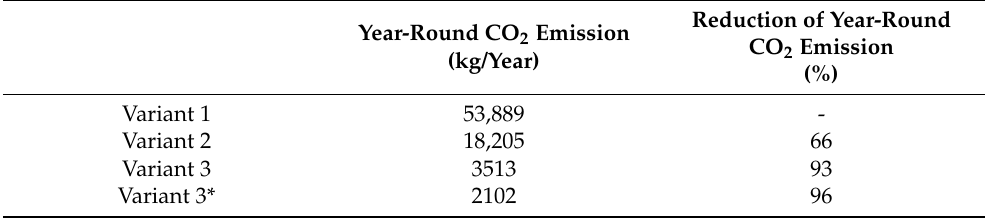
Table 6. Year-round CO 2 emission by the building for all calculation